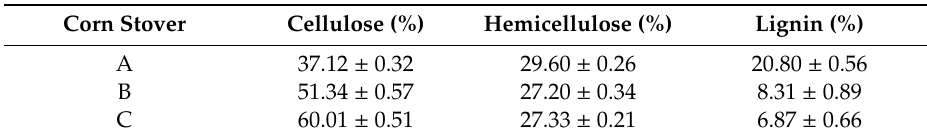
Table 1. The composition of di ff erent corn stover in this study. A: Raw corn stover. B: NaOH pre-treated corn stover. C: NaOH pre-treated corn stover and washed corn stover.